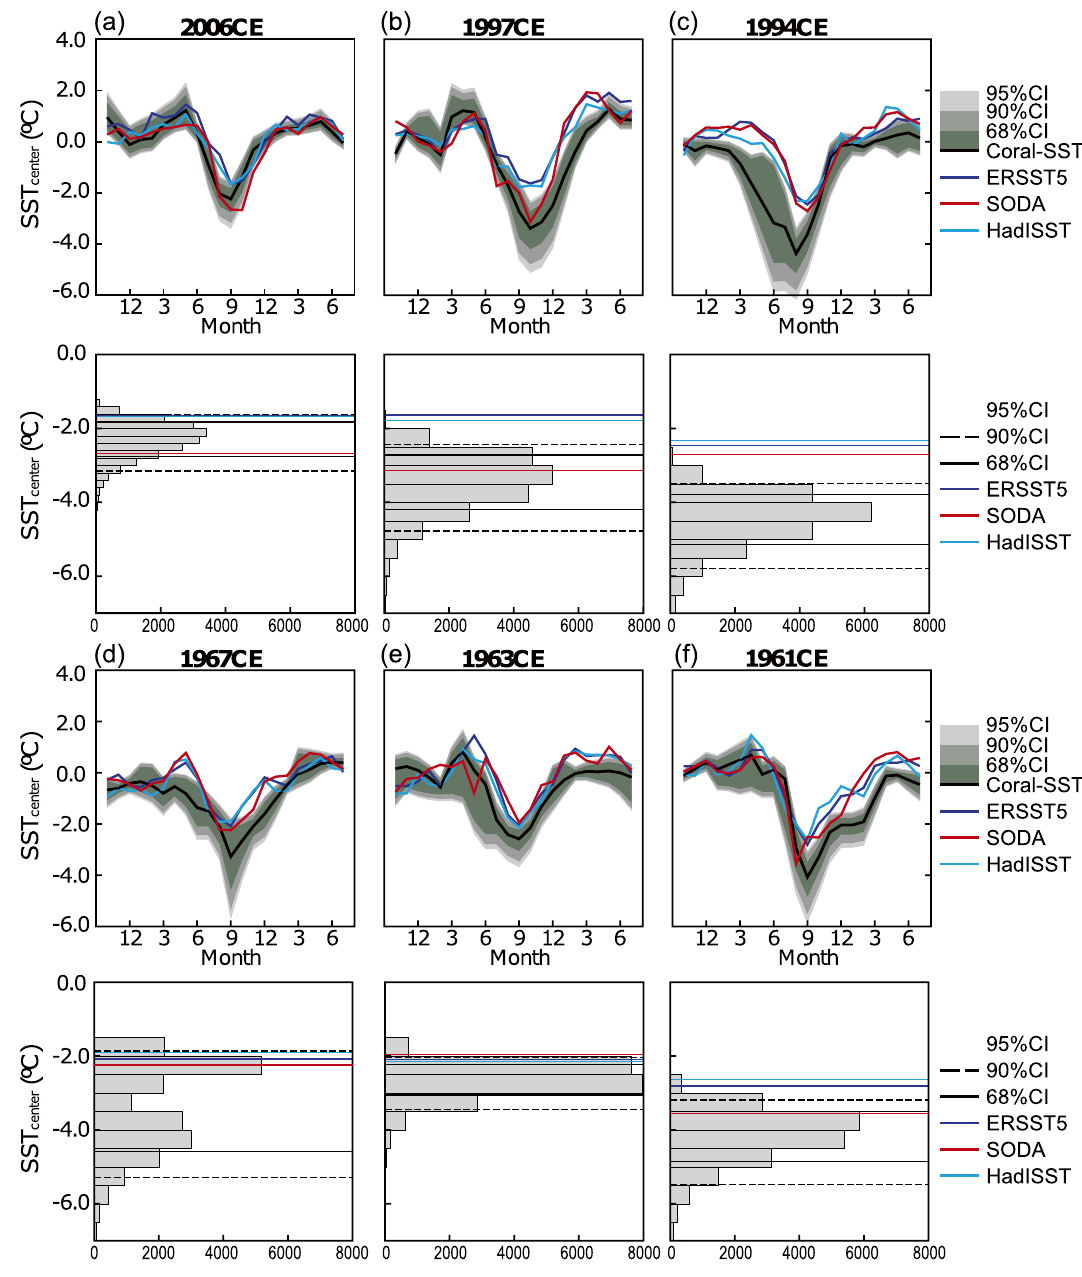
Figure 6. Time series of monthly Enggano SSTs and its uncertainty (black lines and gray shading, upper panel) and histogram of Enggano SSTs estimated from a Monte Carlo simulation that accounts for proxy error for the peak of the pIOD events of 2006, 1997, 1994, 1967, 1963 and 1961. Enggano SST is compared with ERSST5 (dark blue), SODA2 (dark red), and HadISST1 (light blue). Coloured lines on the histograms of Enggano SST are the SST minima in each pIOD year (ERSST5: dark blue; SODA2: dark red; HadISST1: light blue). Thick, dashed, and dotted lines are 68, 90, and 95 percentiles of the Enggano SST minima during pIOD years. See text for